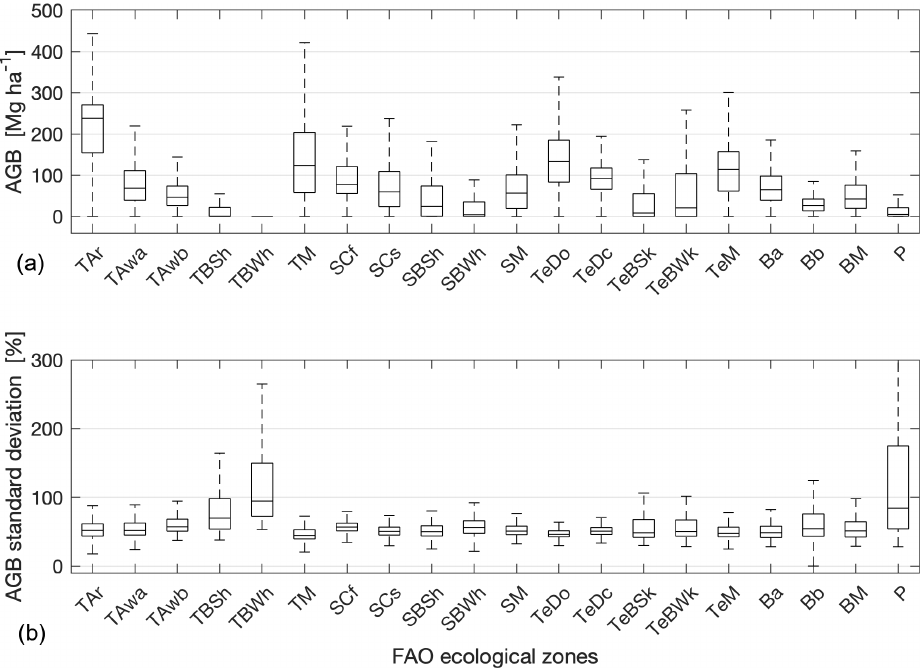
Figure 6. Box plot diagram of AGB (a) and its standard deviation by FAO global ecological zone. On each box, the central mark indicates the median, the bottom and top edges delimit the interquartile range, and the whisker delimits the 1–99 percentile range. Labels of